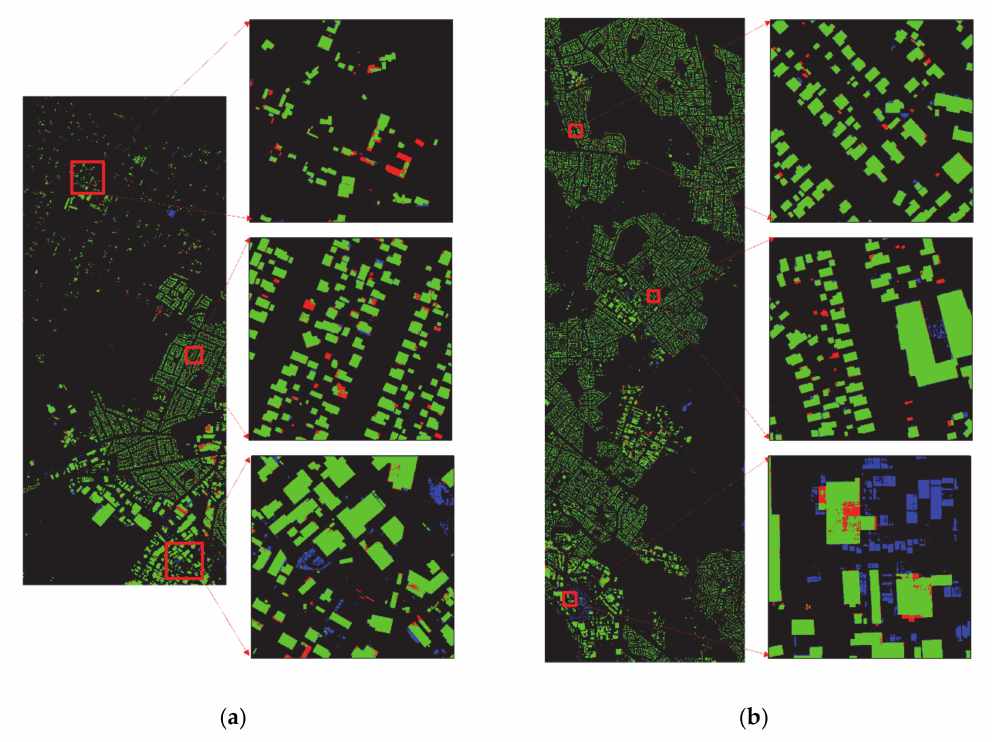
Figure A1. The performance of BRRNet with the dice coefficient loss and batch size set to 1 during training process, ( a , b ) show the building extraction result of the BRRNet on test A and test B area